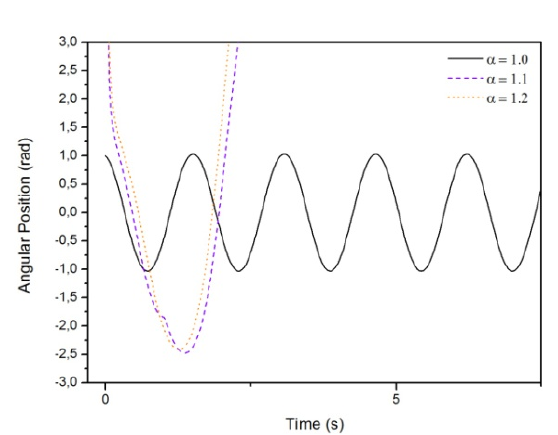
Figure 6. Time history (values of α ≥